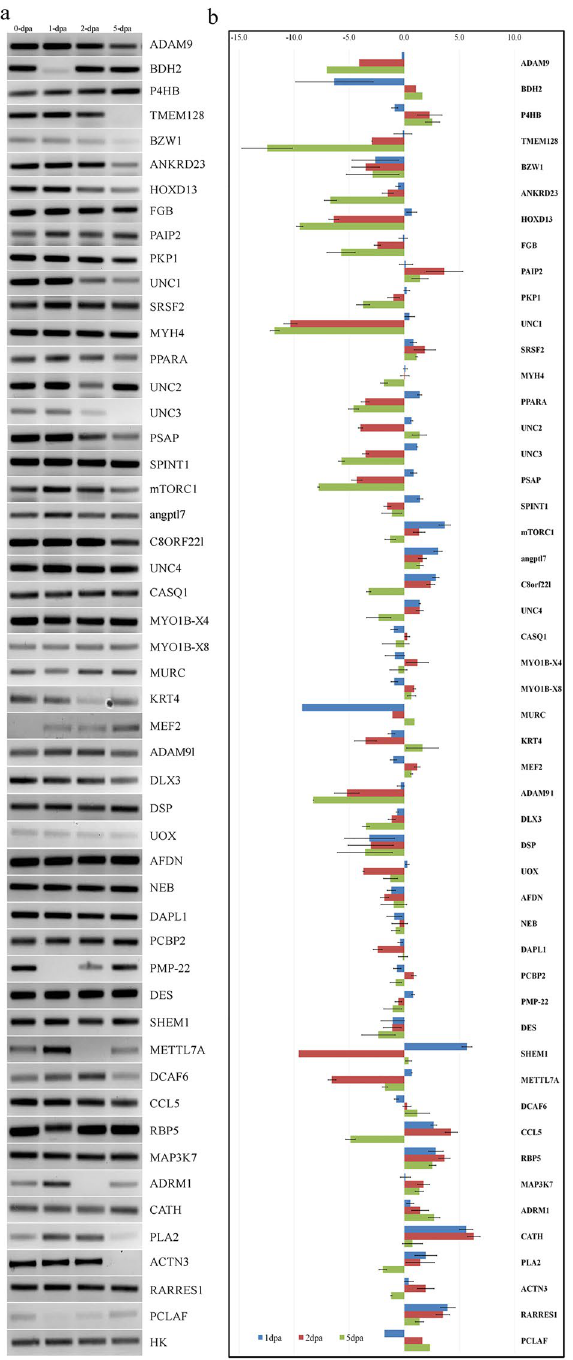
Figure 2. RTPCR analysis of differentially expressed transcripts. ( a ) RTPCR Gel image of all the 50 genes along with housekeeping gene for 0-dpa (control), 1-dpa, 2-dpa and 5-dpa. ( b ) Bar diagram of expression visualising the up and downregulation of the 50